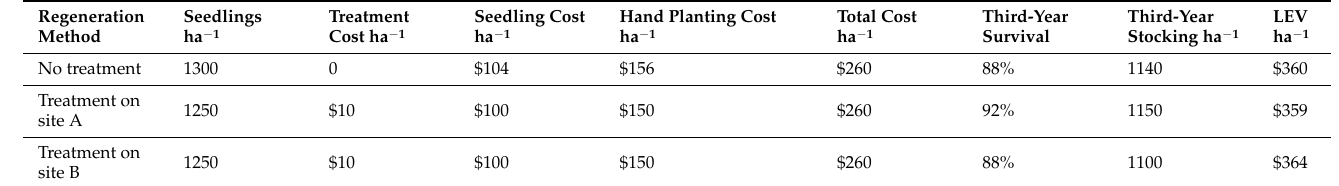
Table 2. Depending on site, investing an extra $10 ha − 1 to improve seedling survival of loblolly pine might affect stocking three years after planting. Alternative A increased survival by 4%, while Alternative B did not increase survival. Land expectation value (LEV @6%) estimated from